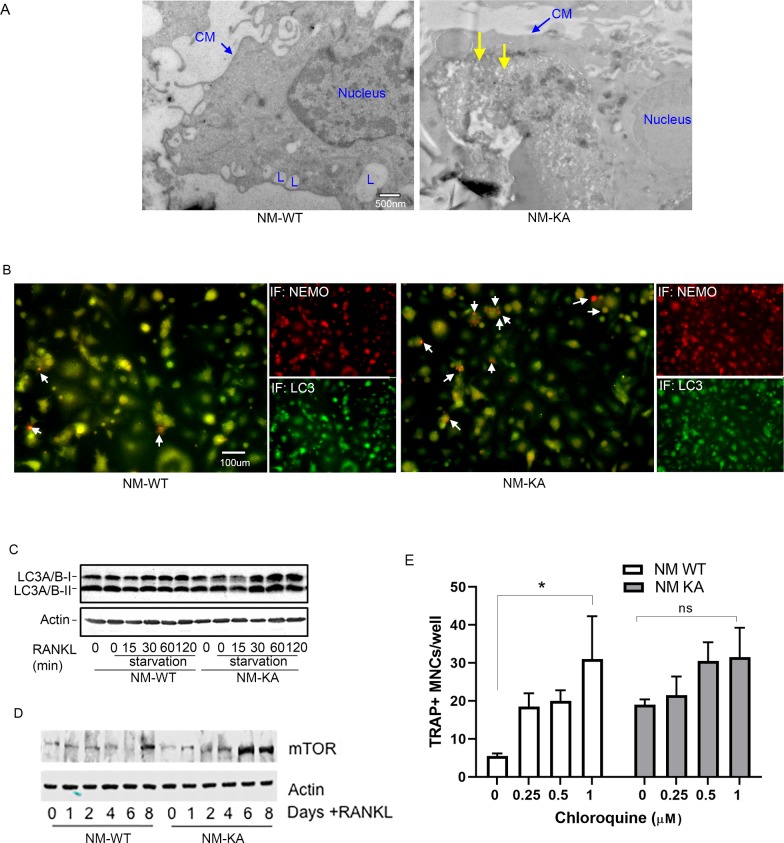
Autophagy is negatively impacted in NEMOK270A cells.(A) Pre-OC (RANKL-treated BMMs) from NM-WT and NM-KA mice were pelleted and processed for electron microscopic and Immunofluorescence (IF) analysis after 6 hr of serum starvation. Representative Electron microscopic images (x7500) showing nucleus, Cell membrane (CM) lysosome (L) in NM-WT preOC and cytoplasmic aggregates (yellow arrow) in NM-KA preOC. (B) Representative IF images for NEMO (red), LC3 (green) and NEMO-LC3 colocalization (yellow). Arrows indicate accumulation of NEMO in LC3 positive vacuole-like structures. (C) Representative western blot showing expression of LC3 from BMMs starved and stimulated with RANKL as shown. (D) Representative Western blot for mTOR expression in BMMs from NM-WT and NM-KA mice treated as shown. (E) Pre-osteoclasts were treated with chloroquine as indicated and number of TRAP+ multi nucleated osteoclasts (MNC) per well were counted in triplicate wells from three independent experiments (*p<0.05).